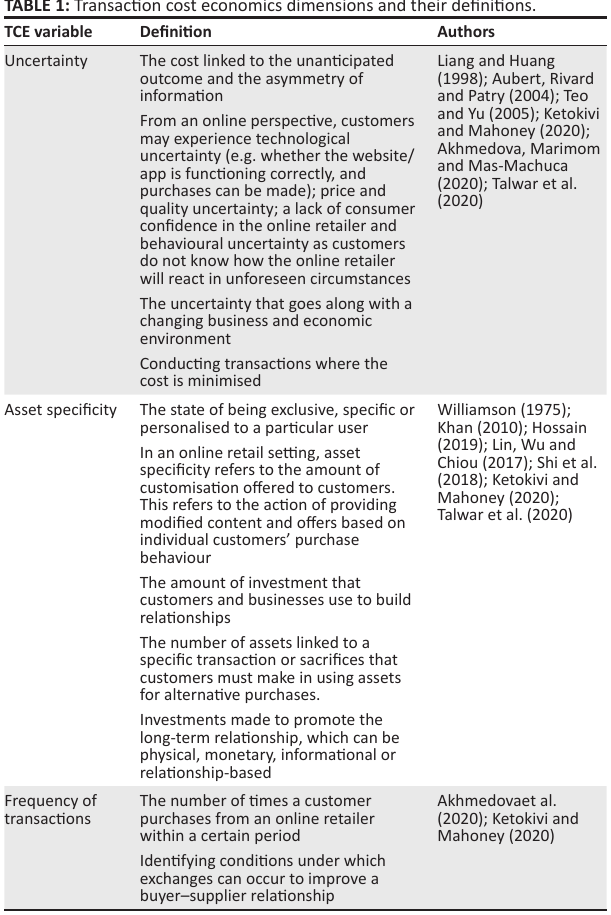
e-B2C retail context.